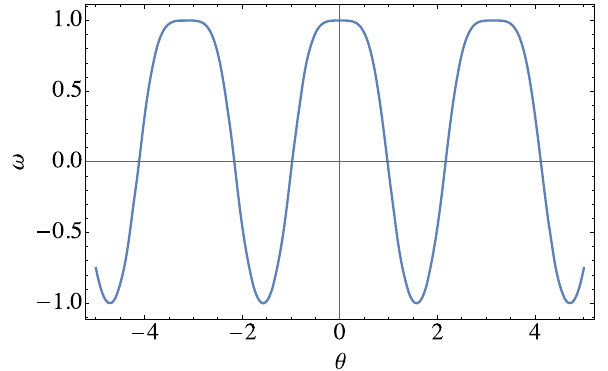
Fig. 2 Variation of Higgs field equation of state ω with periodicity θ for the non-local